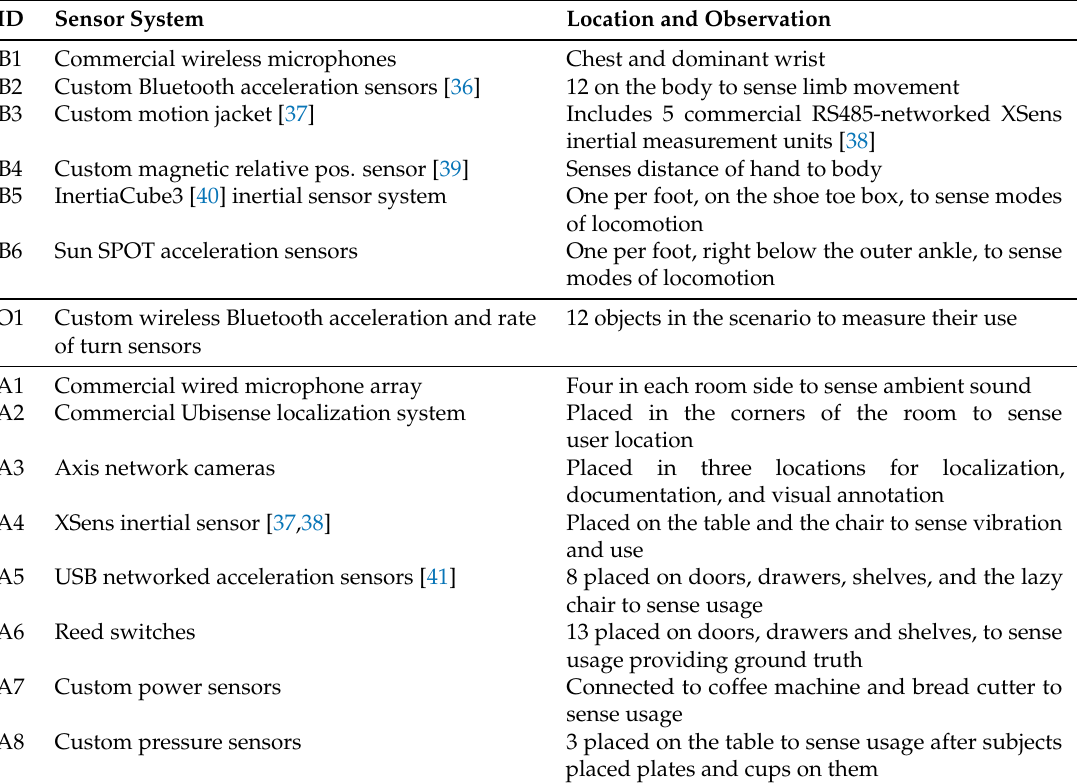
Table 2. Sensors used in the OPPORTUNITY dataset, placed over the body, the objects, and the